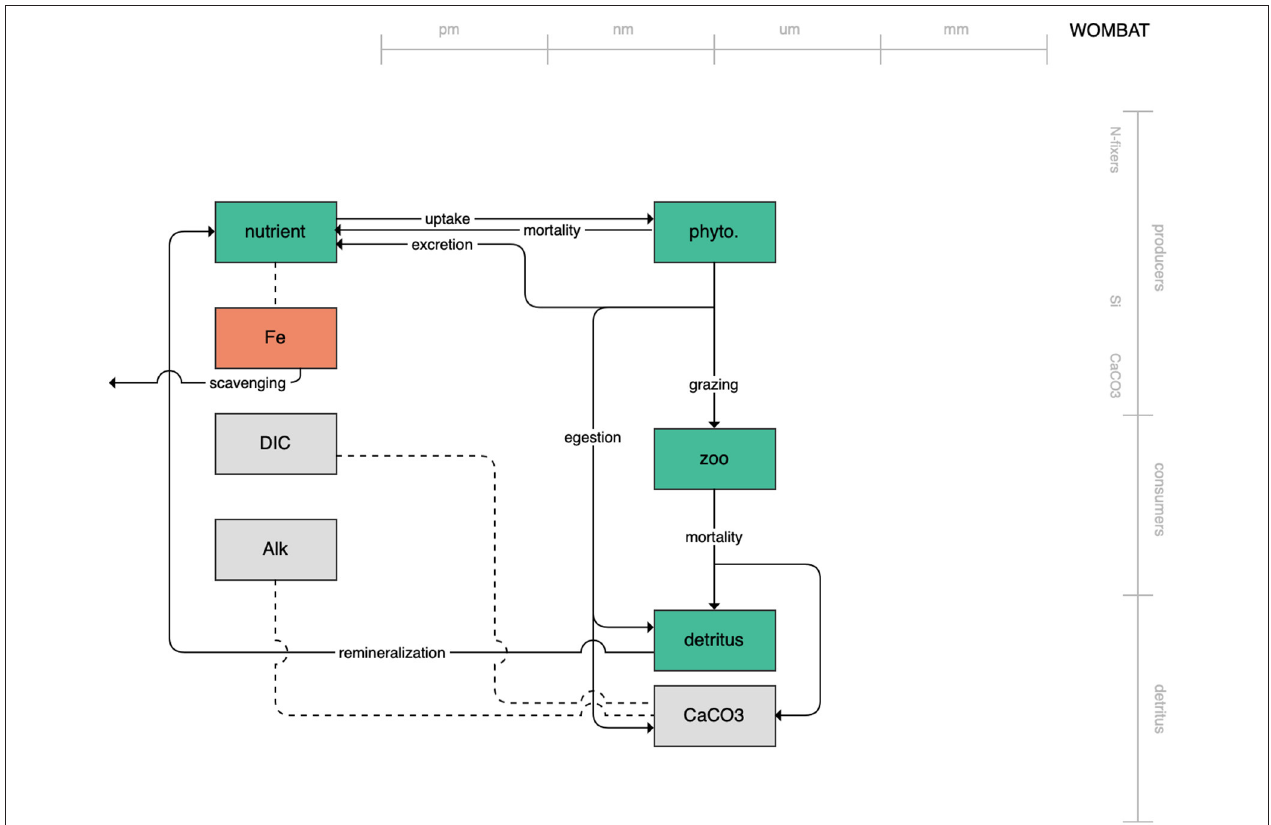
FIGURE 3 | Schematic for the WOMBAT model. See Figure 1 caption for